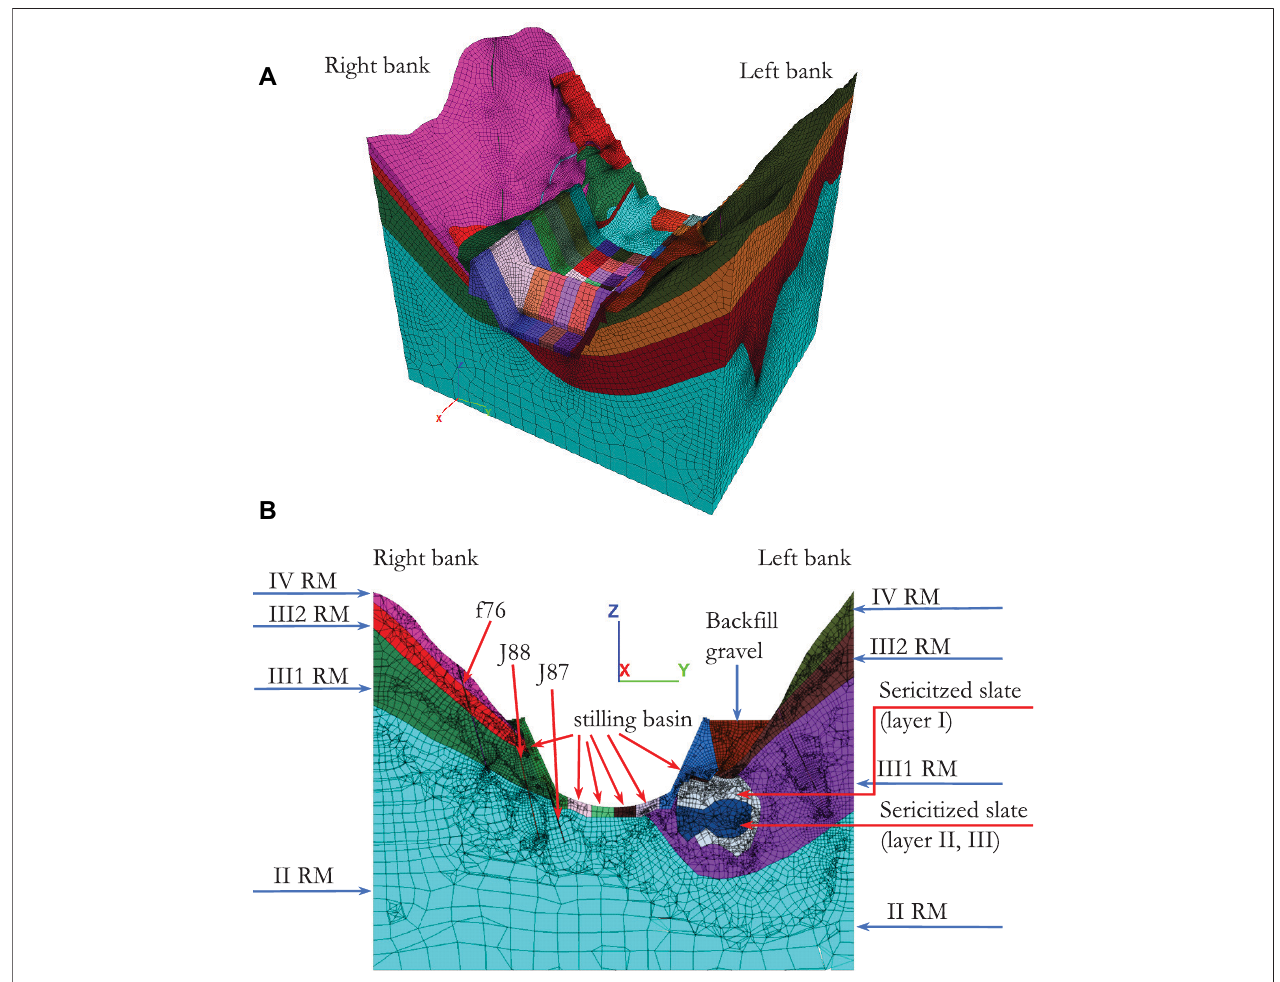
FIGURE 1 | (A) Numerical model of the stilling basin of Kala Hydropower Station and the valley at the dam site, (B) A pro fi le across the river (Dam 0 + 145.25 m) showing the lithological strata and geological conditions.